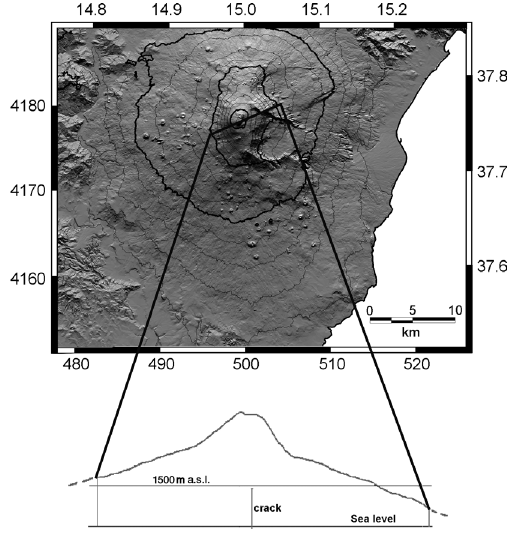
Fig. 3. Map of Mt. Etna with near E-W section to- pography and dike